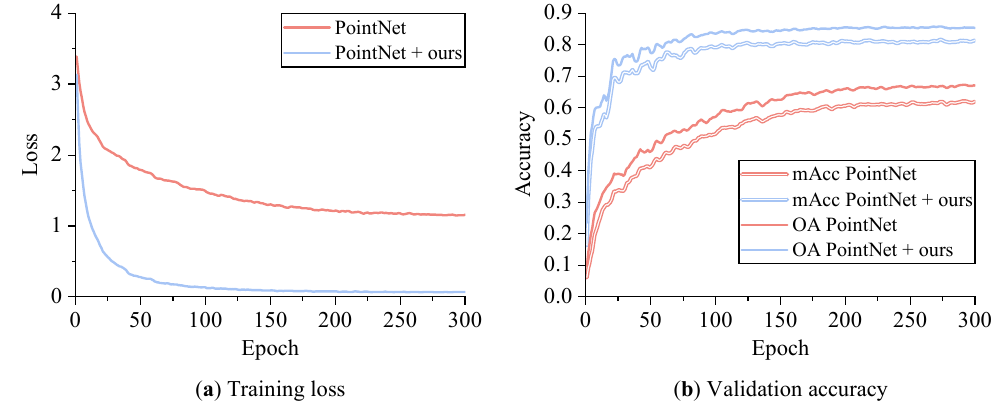
Figure 10. Training curves for 3D object classification using the PointNet backbone [7] on randomly rotated objects from the ModelNet dataset